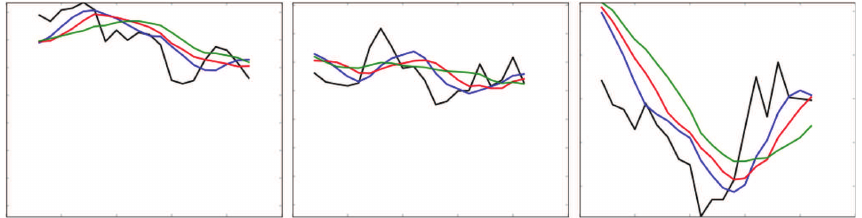
Figure 18: Experiment 1 with Label 1.